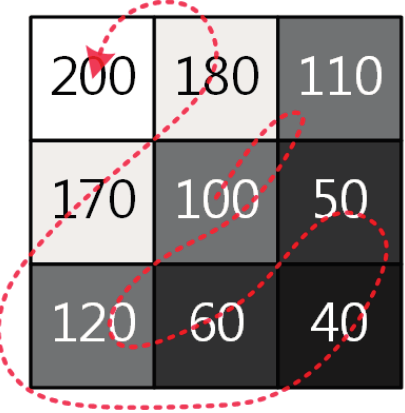
Figure 5. An example of a 3 3 × window with ( , ) 100 g x y = at the